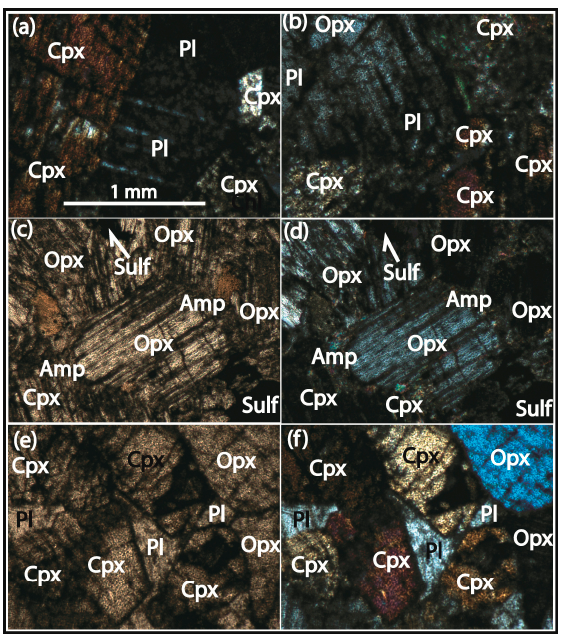
Figure 7. Scale bar shown in ( a ) is the same for all photomicrographs. ( a,b ) crossed polars, sample MusIRUP01: shown in ( a ) are very coarse-grained clinopyroxene (Cpx) crystals enclosed by poikilitic plagioclase (Pl) displaying polysynthetic twinning. Both clinopyroxene and plagioclase are hydrothermally altered. Shown in ( b ) are hydrothermally altered clinopyroxene and orthopyroxene (Opx) with anhedral plagioclase occupying the interstices between the pyroxenes. Near the center on the right of the photomicrograph is a twinned fine-grained clinopyroxene crystal. ( c , d ) are views in plane polarized light and crossed polars, sample PxaFwt01 showing very fine-grained sulfide grains interstitial in orthopyroxene crystals. Amphibole (Amp) occurs as an alteration product of orthopyroxene. Both fine- to medium-grained euhedral orthopyroxene and clinopyroxene and anhedral intercumulus plagioclase under plane polarized light ( e ) and under crossed polars ( f ),